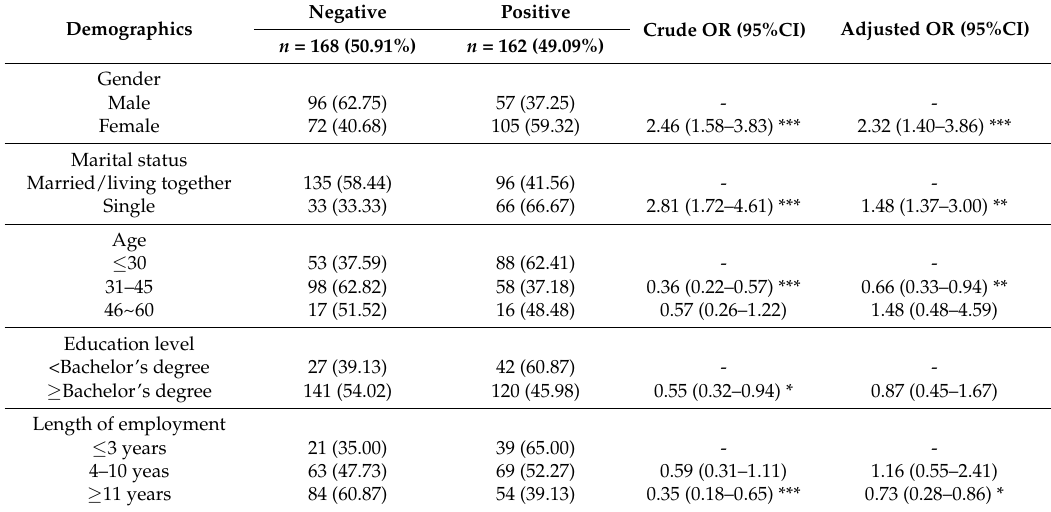
Table 4. Factors that are associated with overall detection rate of participants’ mental health issue. Demographics